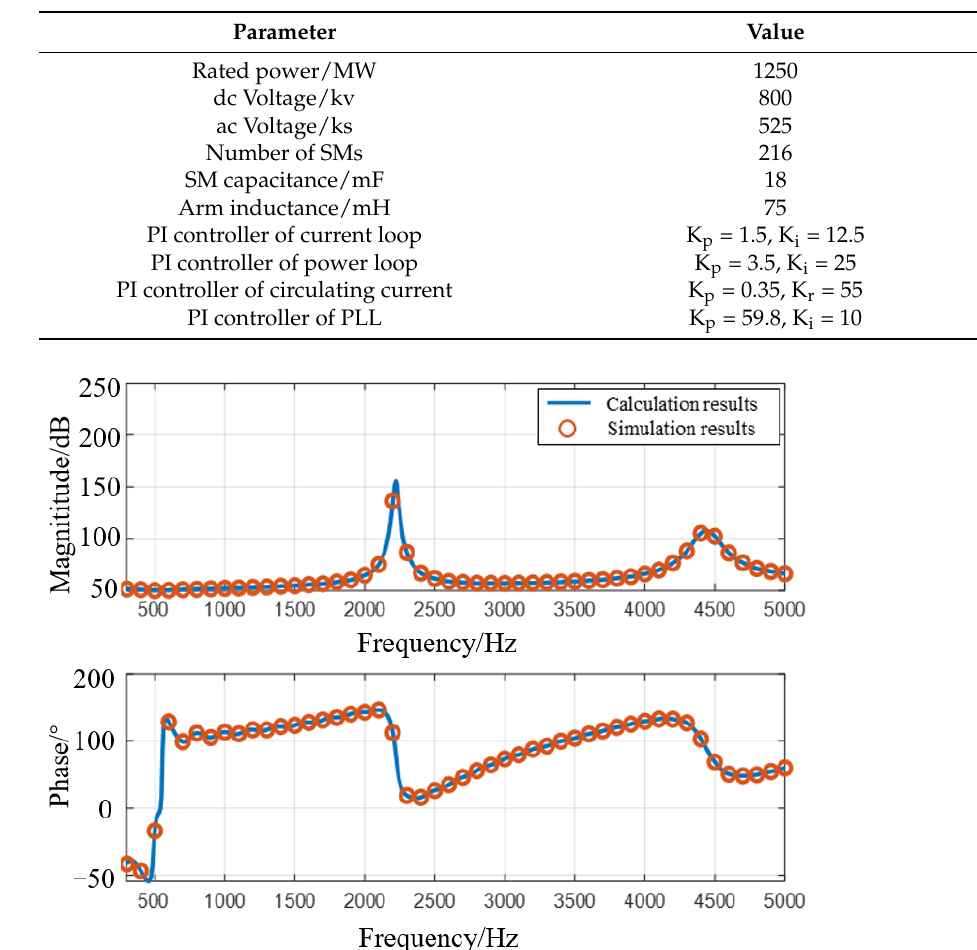
Figure 7. RTDS verification of MMC high-frequency impedance model.